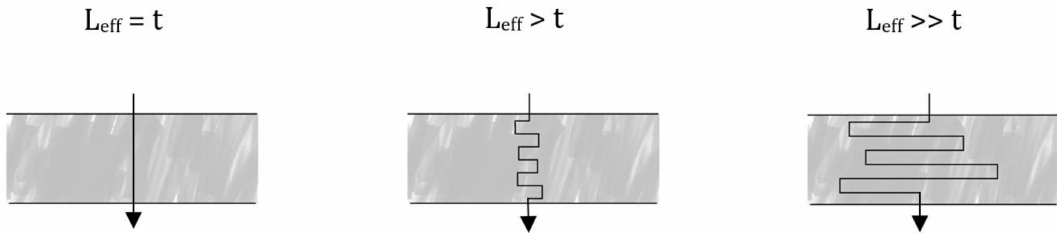
Figure 3. Illustration of the concept of effective pore length ( L eff ) relating it to the filter thickness ( t ) for different degrees of tortuosity.